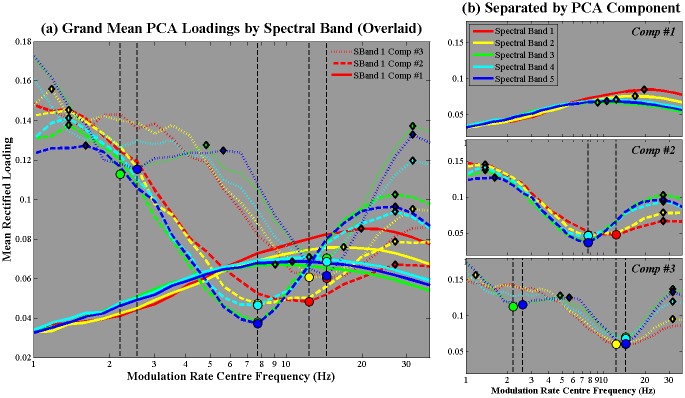
Modulation rate PCA resulting loading patterns.Mean rectified loading patterns for the first 3 principal components obtained for spectral bands 1–5 in the modulation rate PCA, averaged over all speech samples. In (a, left), the PC loading patterns for each spectral band are overlaid. In (b, right), the same loading data is separated by PCs into subplots for clarity. For both (a) and (b), the 5 different colours indicate the 5 different spectral bands. The linestyle (solid, dashed or dotted) indicates the PC number. Coloured circles show local troughs in loading that indicate potential boundaries between modulation rate bands (also marked on the x-axis with vertical dotted lines). The coloured diamonds show local peaks in loading that indicate clusters of modulation rate channels that show strong covariance in temporal patterning. The colour of each circle or diamond reflects its spectral band, following the main colour scheme.